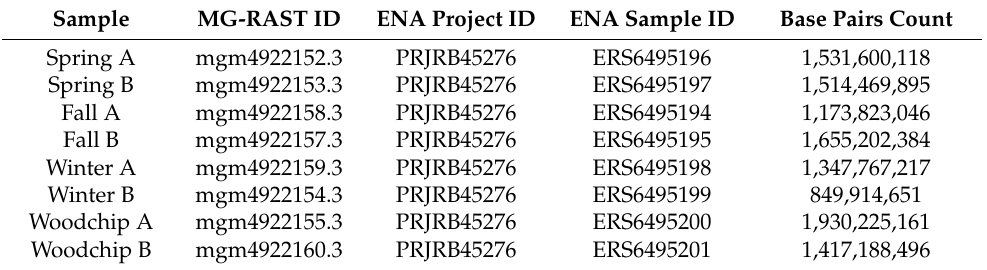
Table A1. DNA sequences lengths and IDs at the European Nucleotide Archive (ENA) for the metagenomic samples obtained from enrichments started with woodchips from a denitrifying woodchip bioreactor located in Denmark and environmental samples (fresh woodchips from the bioreactors). Samples for enrichments were collected in different seasons (spring, fall, and winter) and the woodchip samples were gathered in winter.